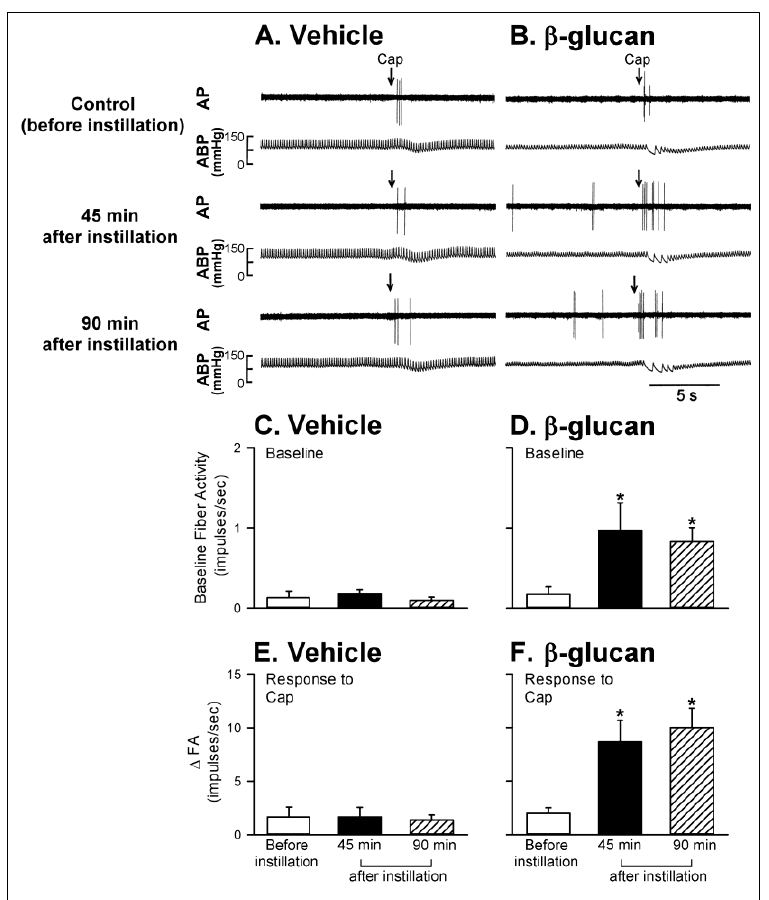
Figure 6. Experimental records illustrating the responses of capsaicin-sensitive lung vagal (CSLV) a ff erents to right-atrial injection of capsaicin (Cap, 0.75 µ g / kg; arrows) before, 45 min after, and 90 min after intratracheal instillation of vehicle or β -glucan in anesthetized, artificially ventilated rats. ( A , B ): intratracheal instillation of vehicle or β -glucan (5 mg / 0.1 mL / rat) in two anesthetized, artificially ventilated rats (vehicle: 350 g; β -glucan: 355 g), respectively. AP, action potential; ABP, arterial blood pressure. ( C , D ): the e ff ects of vehicle and β -glucan on the baseline fiber activity of CSLV a ff erents, respectively. ( E , F ): the e ff ects of vehicle and β -glucan on the responses of CSLV a ff erents to the capsaicin injection, respectively. FA, fiber activity; ∆ FA, increase in the fiber activity was measured as the di ff erence between peak FA (averaged over 3-s intervals) and the baseline FA (averaged over 10-s intervals) in each CSLV a ff erent. Data are means ± SE ( n = 8). One-way ANOVA followed by Newman-Keuls post hoc test: *, significantly di ff erent from before instillation ( p < 0.05). Please note that the β -glucan instillation caused an elevation in baseline FA; furthermore, the ∆ FA triggered by capsaicin injection was also enhanced by β -glucan